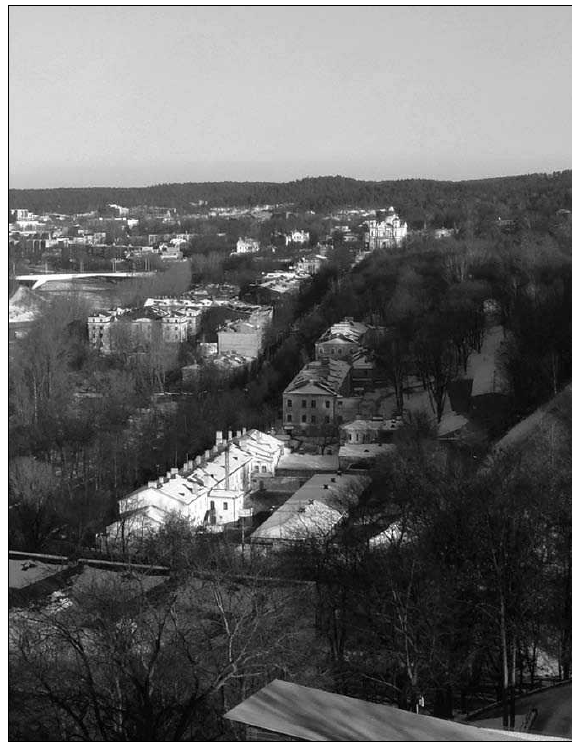
Fig. 4. t. kosciuška street. View from Gediminas